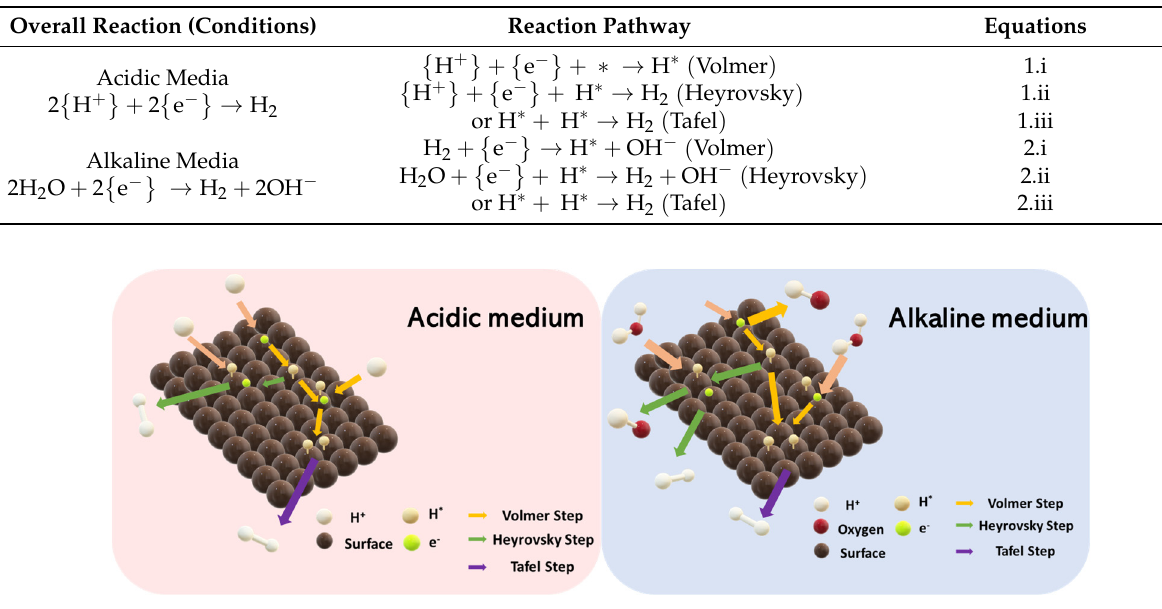
Figure 7. Electrocatalytic Hydrogen Evolution Reaction in Acidic and Alkaline Conditions. A summary of pertinent Cu-based semiconducting materials is listed on Table 2 (photocatalytic H 2 production), Table 3 (electrocatalytic H 2 production) and Table 4 (photoelectrocatalytic H 2 production). Hereafter, we highlight some engineering aspects related to the control/improvement of hydrogen evolution by such catalysts.